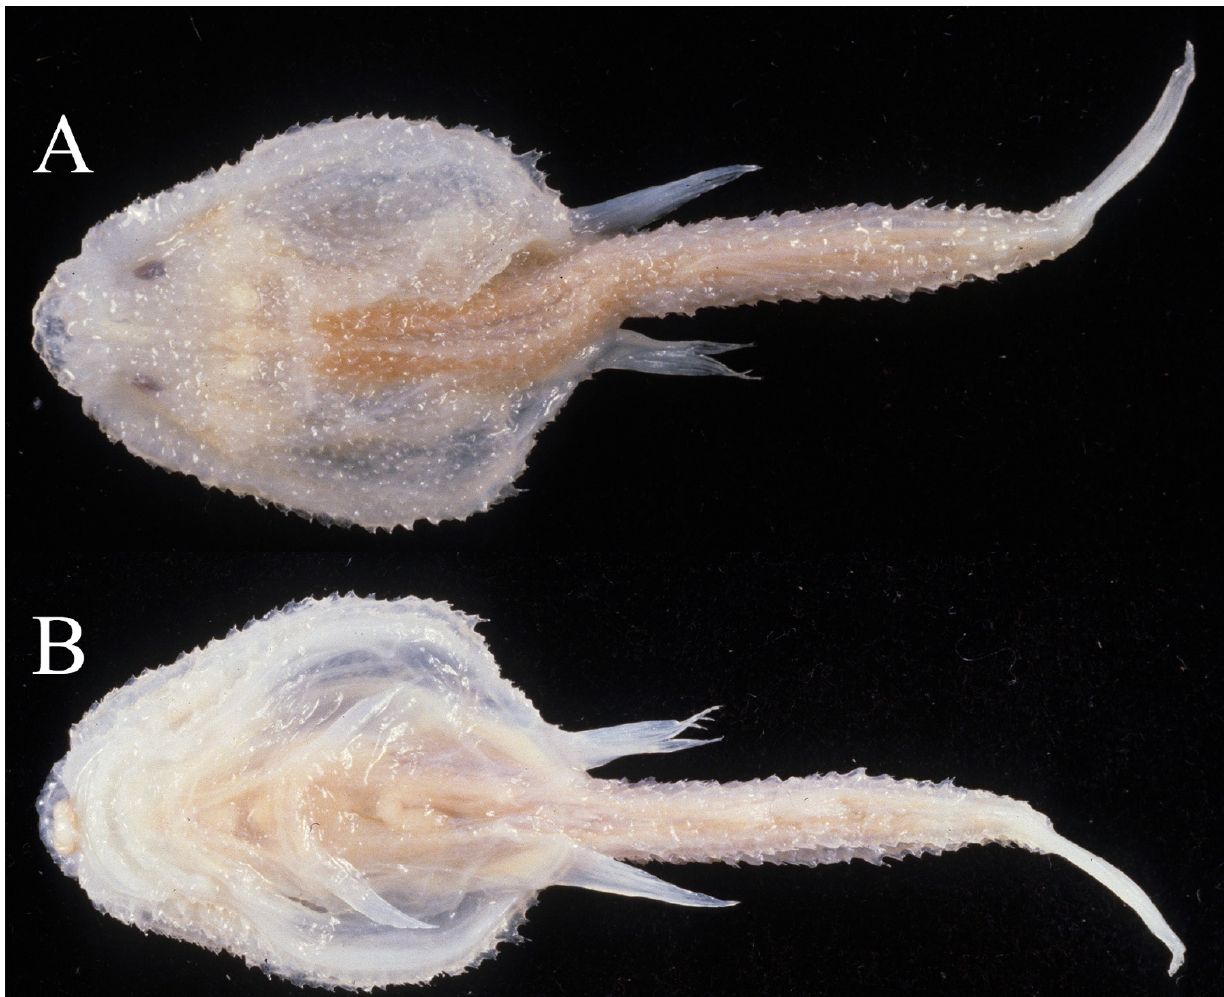
Figure 1. Halieutopsis andriashevi Bradbury, 1988, holotype, SIO 61-14-65A, 46.2 mm SL, Indian Ocean. ( A ). Dorsal view. ( B ). Ventral view. Photos by M. G. Bradbury. Diagnosis . Dorsal-fin rays 4–5; pectoral-fin rays 14–15. Disk small and tail long. Esca small, its dorsal lobe with tongue-like structure and thin posterior flap (Figure 2B). Tubercles on edges of disk and lateral sides of tail low and closely adjoining, forming thin, continuous, saw-toothed ridges; subopercular tubercle poorly developed, with two short spinelets (Figure 2C–E). Proportional measurements relatively small compared to other species: eye diameter 24.9–27.0% SL; disk margin 34.4–38.2% SL; head width 17.3–22.7% SL; dorsal-fin length 14.5–15.1% SL; pectoral-fin length 18.0–20.4% SL; anal-fin length 14.1–15.1% SL; caudal-fin length 24.2–24.7% SL (Table 3). Lateral-line neuromasts: SS 3–6, POS 2–3, SOS 5, DBSS 3, vs. 1–3, TS 8–11 (Tables 1 and 2). Preserved coloration light brown to creamy white, somewhat translucent with thin